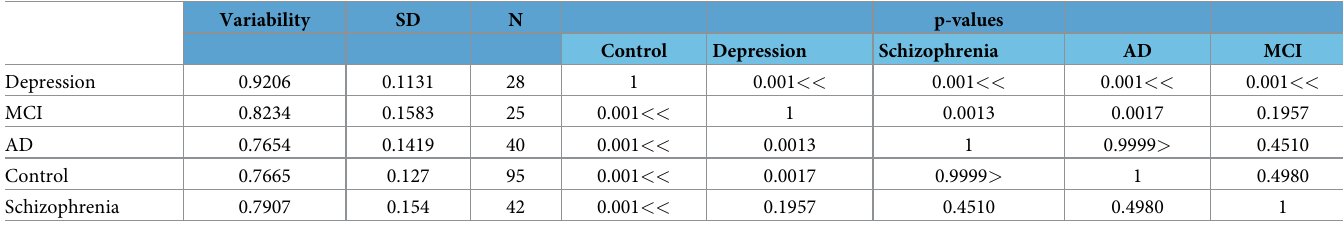
Table 5. Cross correlation analysis between participant’s electrodes–lag.